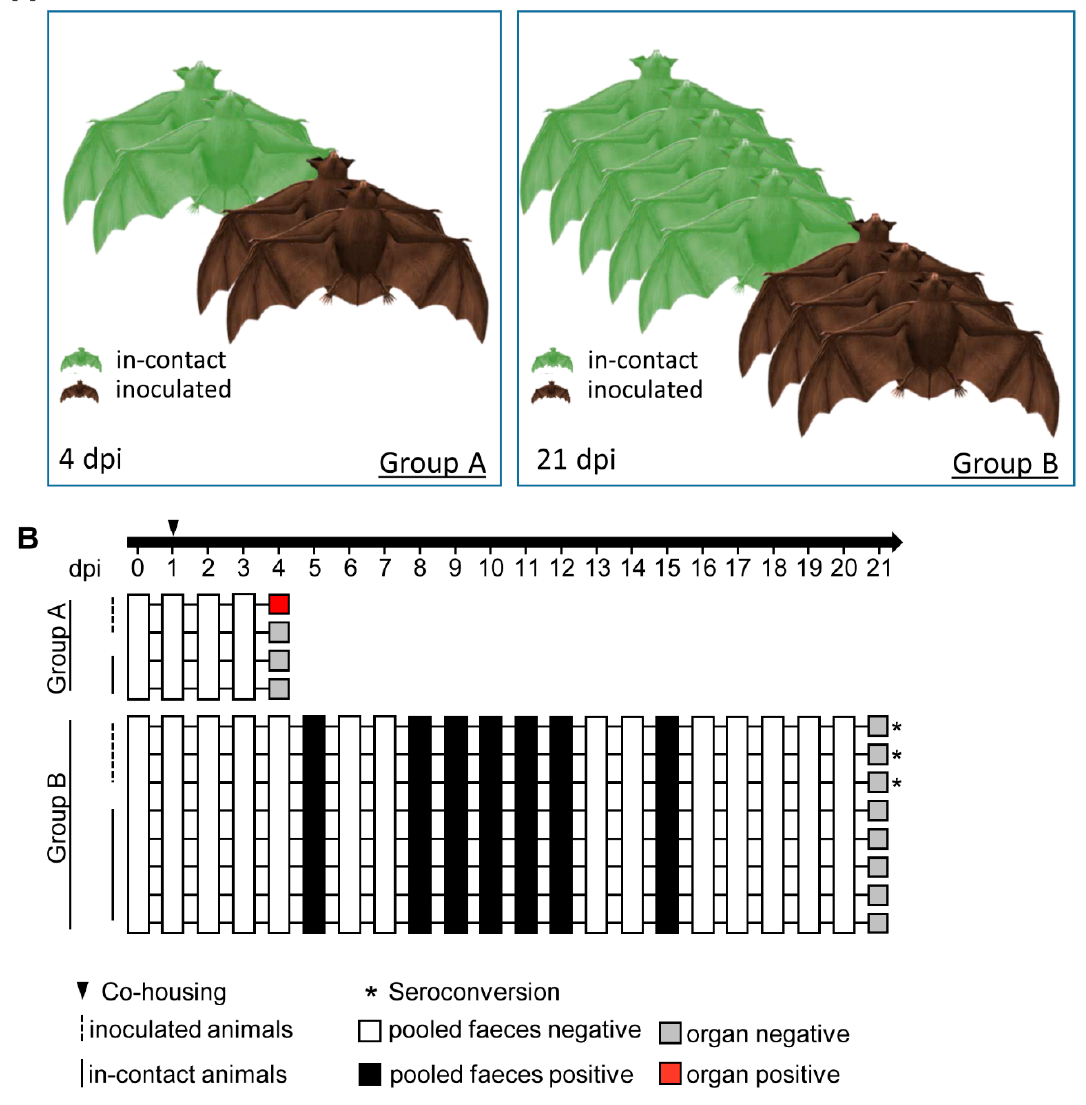
Figure 1. Experimental design. ( A ) Group A consisted of two inoculated bats in direct contact to naïve bats co-housed in one cage. At 4 dpi, the animals were euthanized and the organ material analyzed. Group B involved three inoculated bats co-housed with five naïve animals until 21 dpi. Group C (not presented) included two Seba’s short-tailed bats for negative tissue control. ( B ) Index bats were inoculated with 10 5.5 TCID 50 of H18N11 oronasally. Pooled feces samples were taken at the indicated time points. White squares indicate absence, black squares the presence of viral RNA in feces samples. Grey squares show absence, the red squares presence of H18N11 RNA in at least one organ. Asterisks indicate seroconversion.